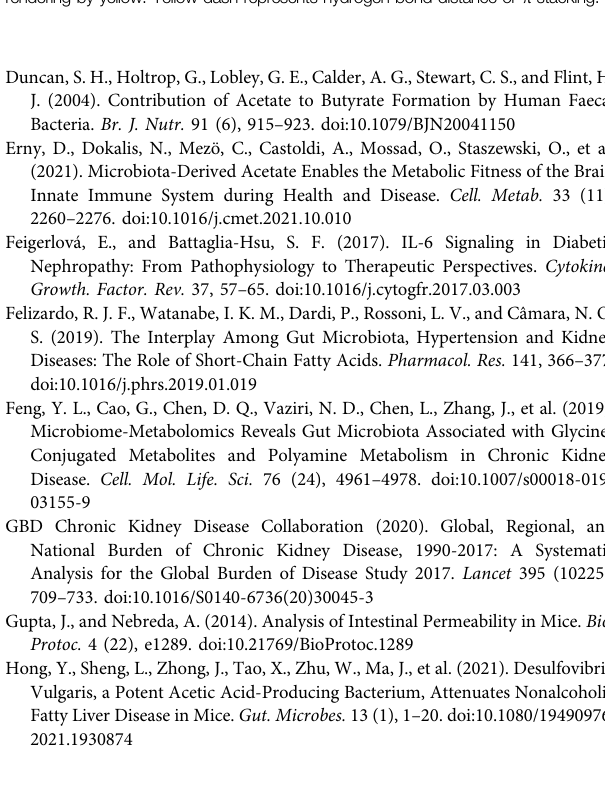
Supplementary Figure S1 | Fingerprint of YQHG based on UHPLC-MS approach. Supplementary Figure S2 | The information of Quercetin and Kaemferol. (A) Extracted and ampli fi edthe peak graph for the twocomponents. (B) Thesecondary mass spectrometry information of the two components. Supplementary Figure S3 | ThebindingmodeofIL-6protein withQuercetin. (A) The 3D structure of complex. (B) The surface of active site. (C) The detail binding mode of complex.Thebackboneofproteinisrenderedintubeandcoloredingreen.Compoundis rendering by yellow. Yellow dash represents hydrogen bond distance or π